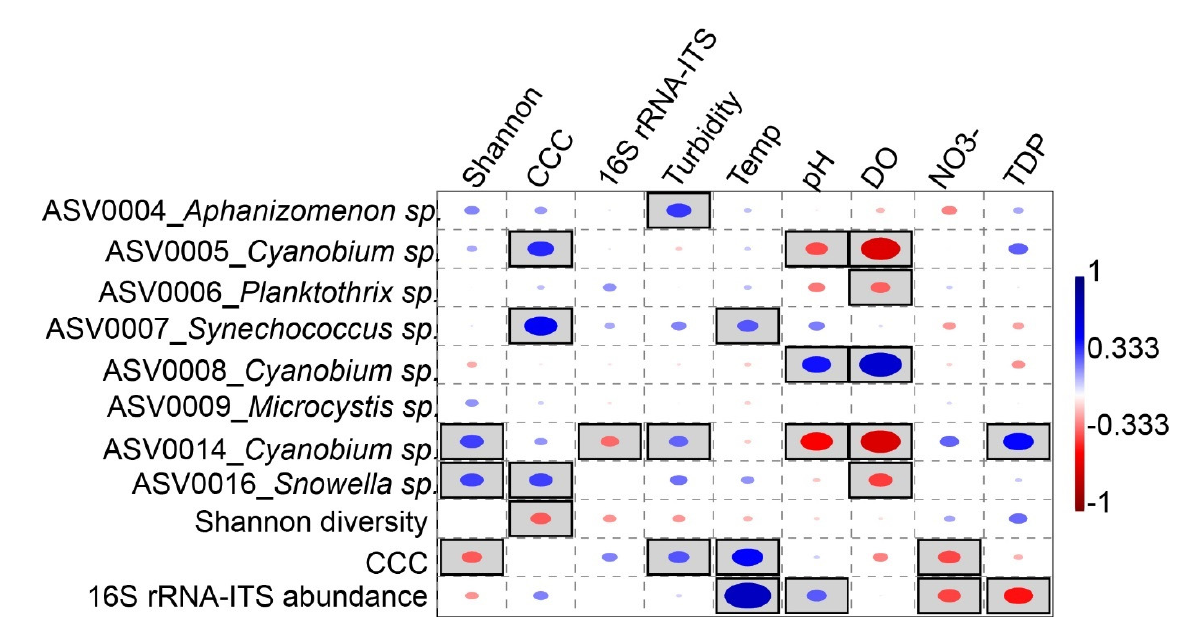
Figure 6. Correlation of pelagic cyanobacteria communities with environmental parameters: Rank-based Spearman correlation coefficients of the most abundant cyanobacteria ASVs, total cyanobacteria composition, and cyanobacteria 16S rRNA-ITS gene abundance with internal physicochemical properties in Lake Tiefer See. Gray-shaded squares are significant at p < 0.05 with Bonferroni p-value correction. Blue circles show positive, whereas red circles show negative correlations. Shannon diversity = cyanobacteria diversity, Temp. = temperature, DO = dissolved oxygen, NO 3– = nitrate, TDP = total dissolved phosphorus, and 16S rRNA-ITS = 16S rRNA gene internal transcriber spacer (ITS) region of cyanobacteria.